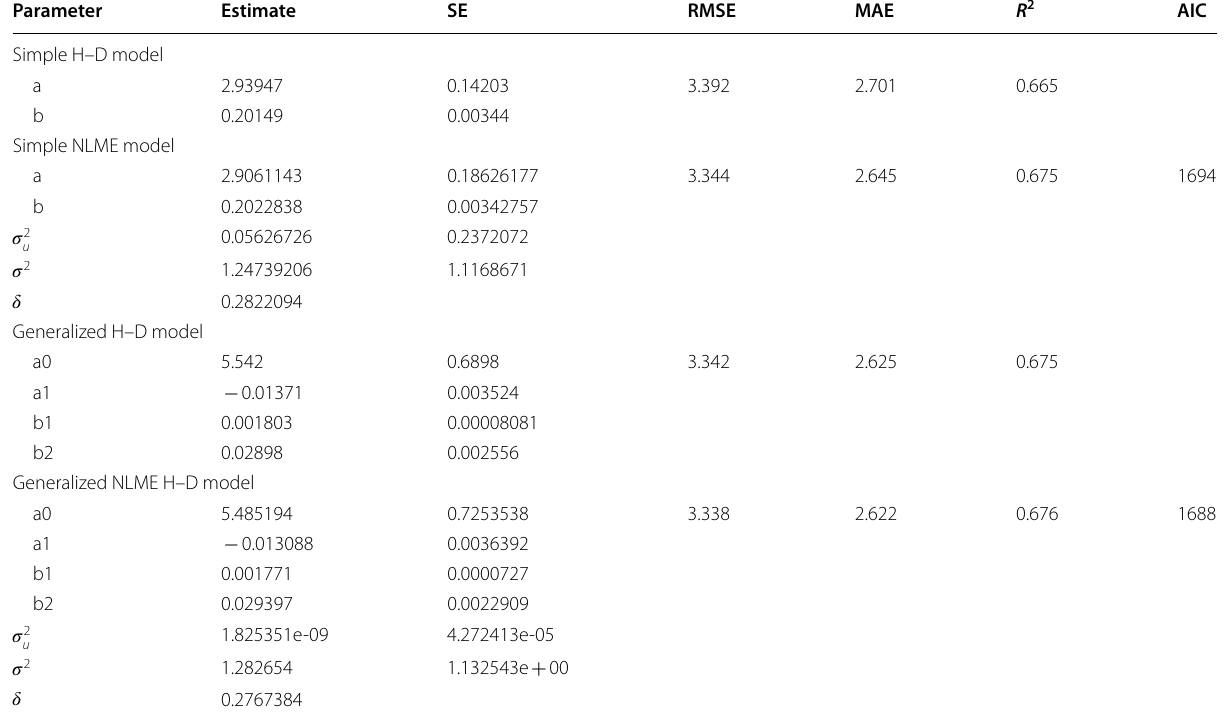
Table 10 Estimated parameters and goodness of fit of the H–D models for N. pumilio , developed on the basis of the fitting database. For estimates for the models fitted to the complete database, see Table 16 in Appendix Parameter